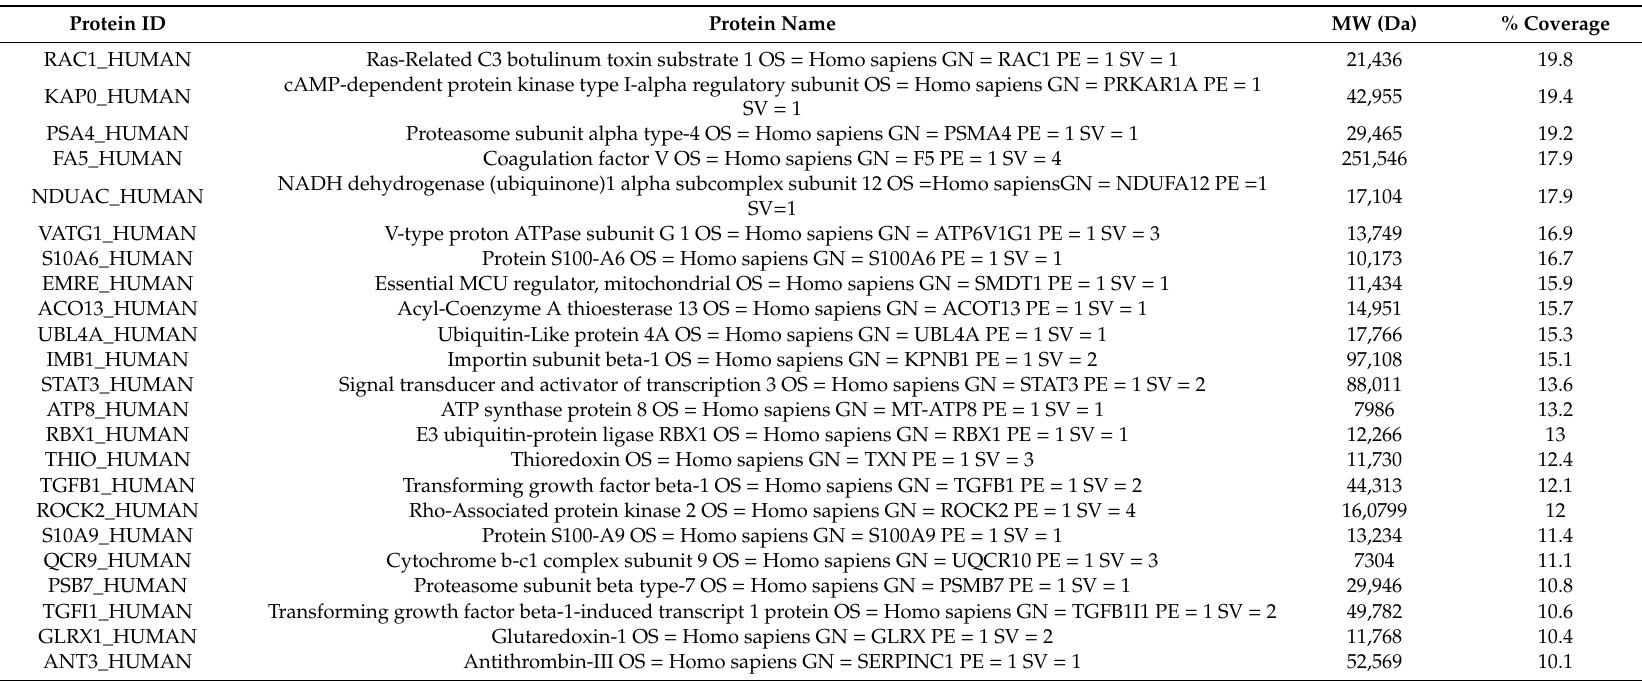
Table 3. Identification of Parkin-interacting proteins in DM platelets (below 20%